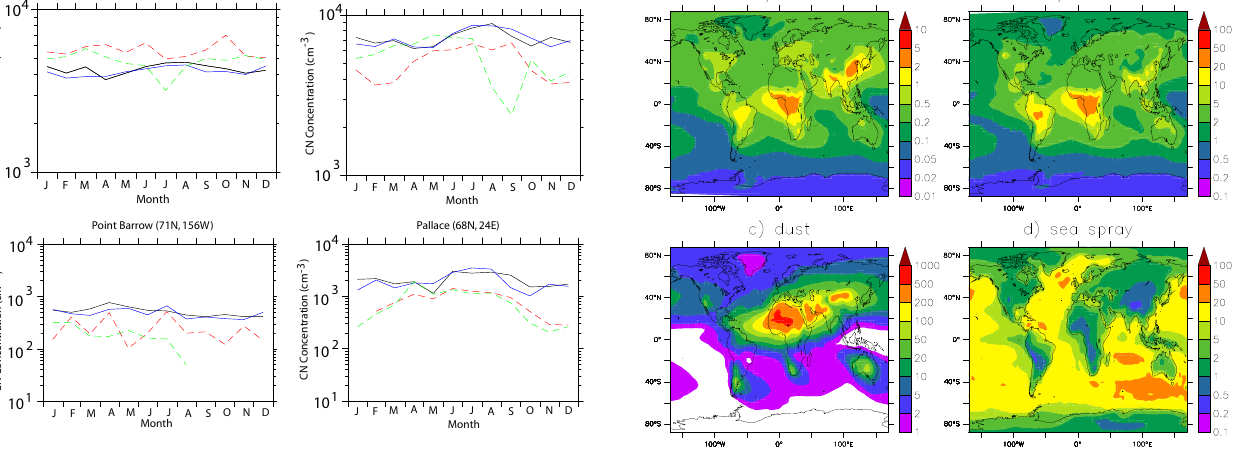
Fig. 6. Annual mean column tropospheric burden of the total con- centration of (a) BC, (b) POM, (c) dust, (d) sea salt. The concen- tration of sea salt is calculated as the sum of sodium and chloride and bulk sea salt concentrations. All units are in mgm − 2